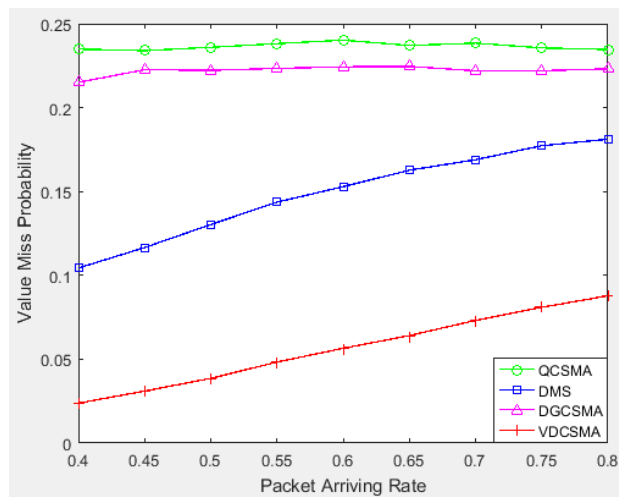
Figure 13. Value missing probability of real-time links: λ ∈ [ 0.4,0.8 ]